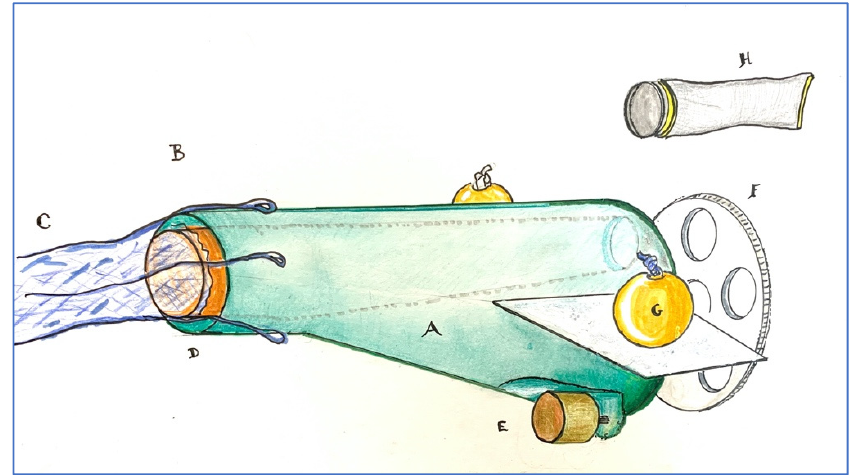
Figure 3. Scheme of the VERDA Multisampler. (A) Fiber glass body. (B) Mouth. ( C ) Mesopelagos net. (D) Attachment. (E) Motor. (F) Plate. (G) Floats. (H) Collector (net).